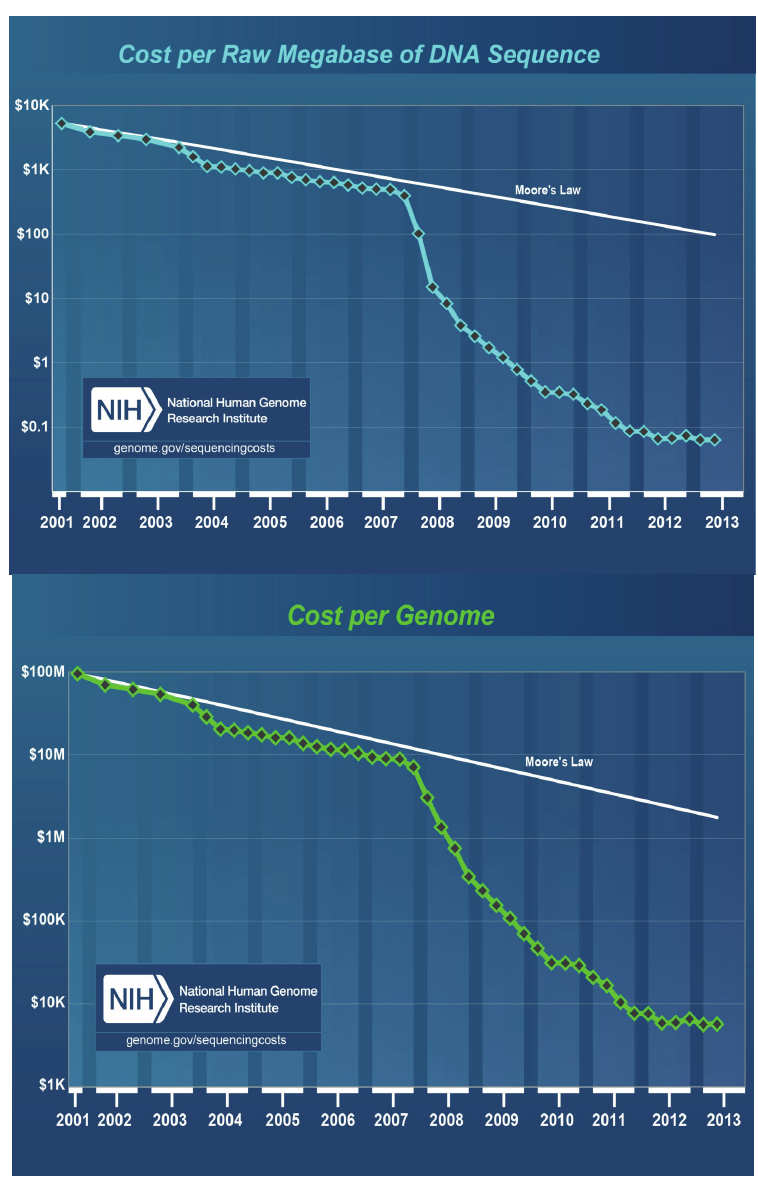
Figure 1. Cost in US Dollars per raw megabase of DNA sequence ( top ) and cost per genome ( bottom ) from July 2001 to July 2013 as estimated by the National Human this time period, first generation sequencing methods were used from 2001 through 2007, then NGS platforms were used from 2008 to